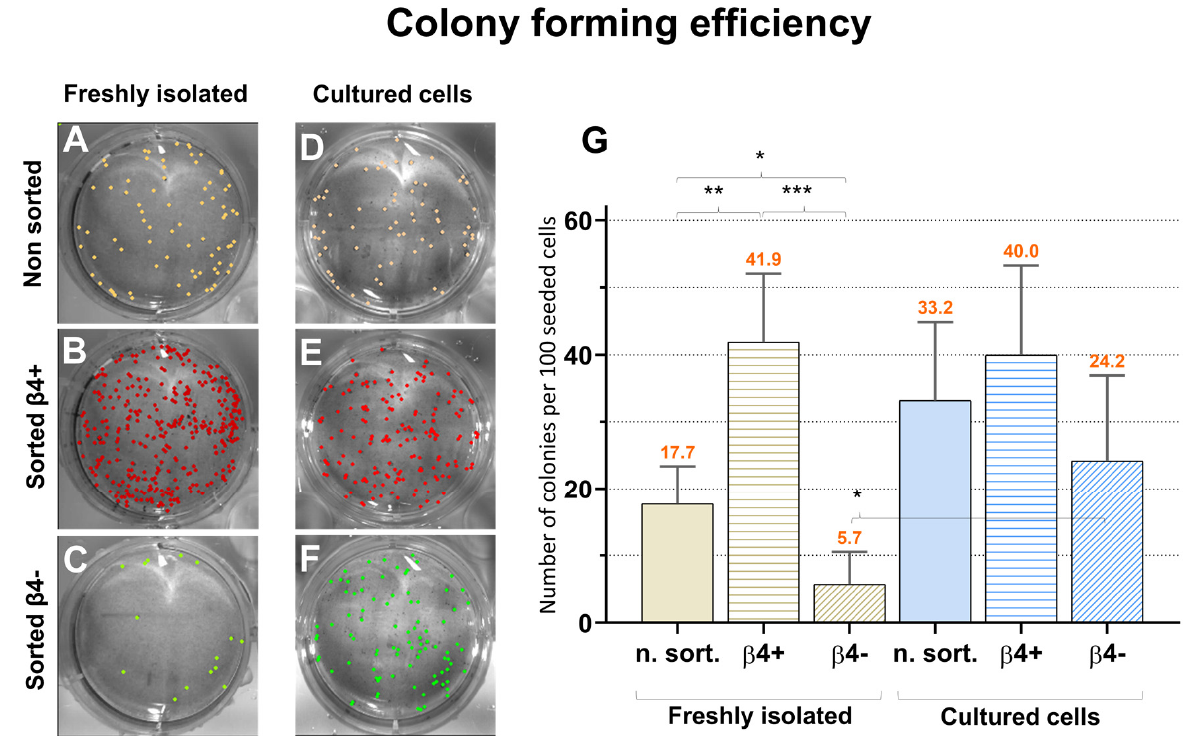
Figure 5. The difference in colony-forming efficiency between basal and suprabasal cells is reduced after 2D culture. ( A – C ) Freshly isolated keratinocytes were sorted and ( A ) 200 unsorted, ( B ) i β 4 + , or ( C ) i β 4 − cells were plated separately on a feeder layer of 3T3-Swiss albino mouse fibroblasts. After 10 days, the formed colonies were visualized by trypan blue staining and counted. ( D – F ) The same was performed with ( D ) unsorted, ( E ) i β 4 + or ( F ) i β 4 − cells which were previously cultured for 15 days on collagen type I. The statistical analysis ( G ) shows the number of colonies formed per 100 seeded cells (means of 8 experiments, standard deviations, and significances from the unpaired t test: * p < = 0.0037, ** p = 0.000547, *** p = 0.000001, n.S = p > 0.05), and indicates that after 2D culturing basal and suprabasal cells own similar colony-forming efficiencies.